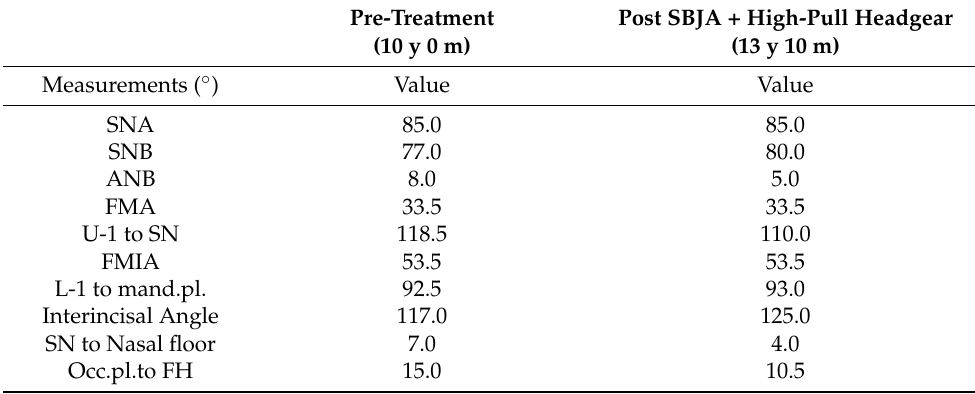
Table 3. Cephalogram angle measurements of Case 2.